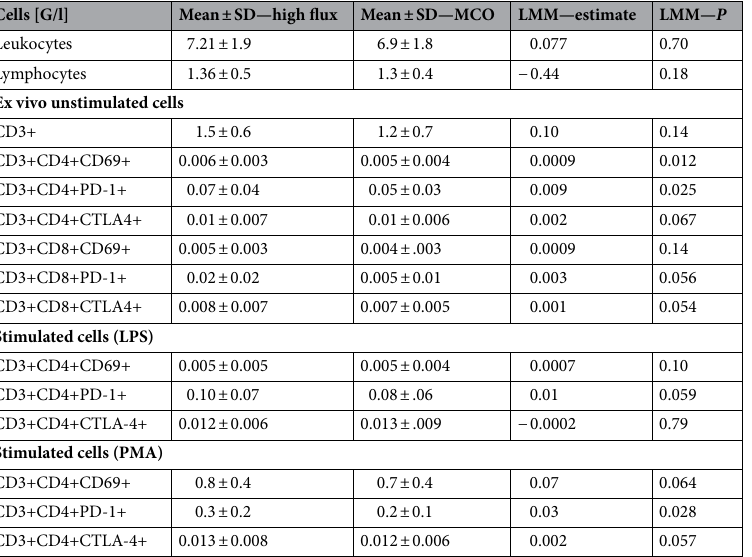
Table 4. Secondary endpoint analysis T cell composition and activation. The impact of treatment on ex vivo cell activation (cryopreserved cells prior to HD session start) was modeled in a linear mixed effects model, with subject ID (nested in sequence) as a random effect and treatment (MCO = 0), period and sequence as the main effects, no significant carry over effect (= sequence not significant) was seen for the reported variables. “Scaled identity” was selected as covariance-structure. Mean values for each treatment are reported at the end of each period (T2 and T4, for a total of 34